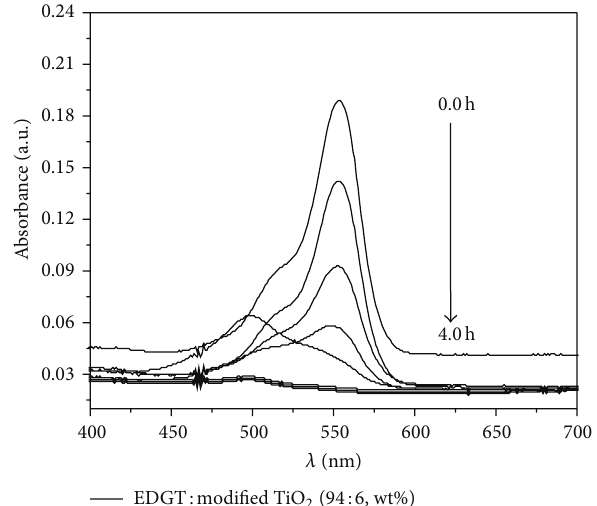
Figure 8: Absorbance spectrum of residues of rhodamine B in the presence of photocatalyst (hybrid ZnO/TiO 2 in fibers) under continuous incidence of light (successive curves were acquired at fixed interval of time of 30 min).